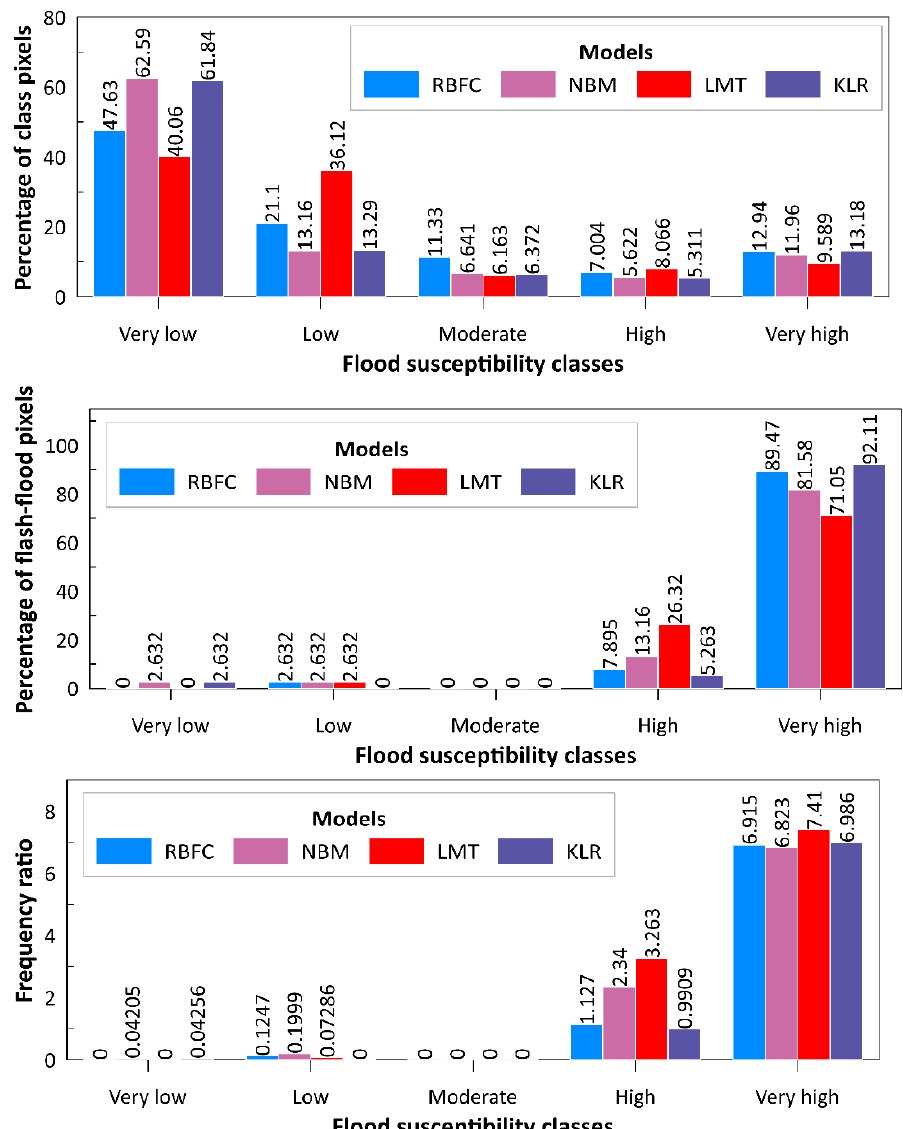
Figure 8. Analysis of the frequency of flash floods on the susceptibility maps (class pixels represents the total number of pixels in whole susceptibility class and flash flood pixels is the total number of flash flood pixels observed in the susceptibility class).